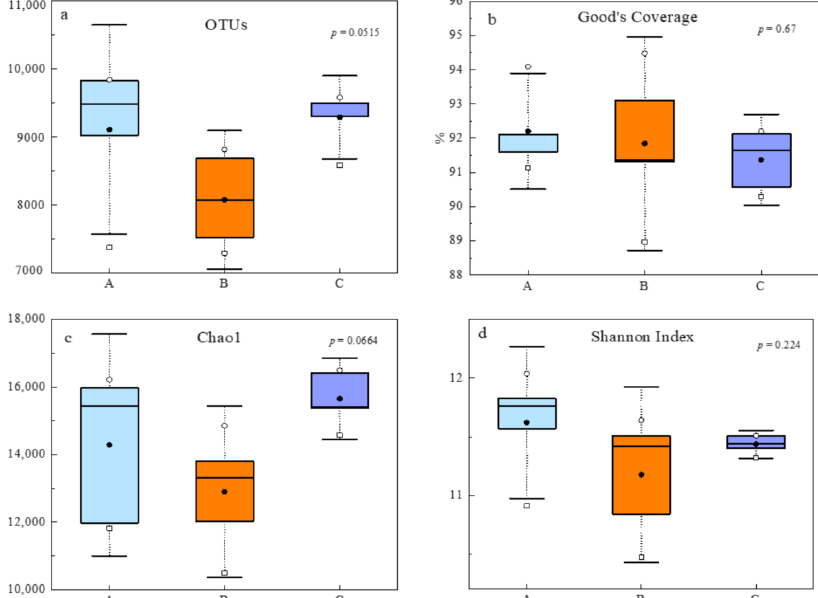
Figure 2. Basic information and α -diversities of microbial communities in soils. ( a ) OTU rich- ness of different sites, defined at the cutoff of 3% sequence difference. ( b ) Good’s coverage, Coverage = 1 − (number of individuals in species/total number of individuals). ( c ) Chao1, reflecting community species richness. ( d ) Shannon’s index, reflecting community diversity. Group statistical significance was assessed by one-way ANOVA followed by Tukey’s HSD test.